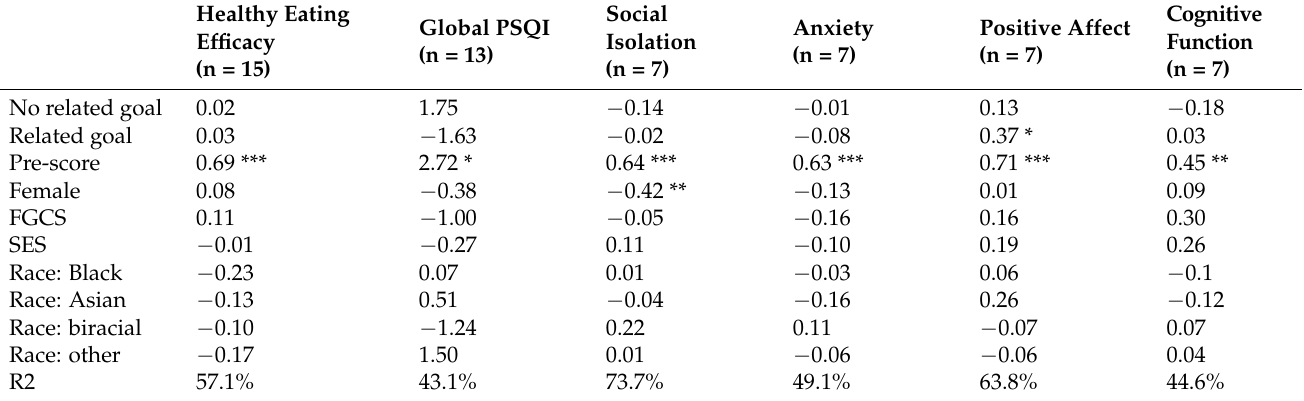
Table 5. Regression analysis on post-coaching parameters of diet, sleep, social isolation, and mental